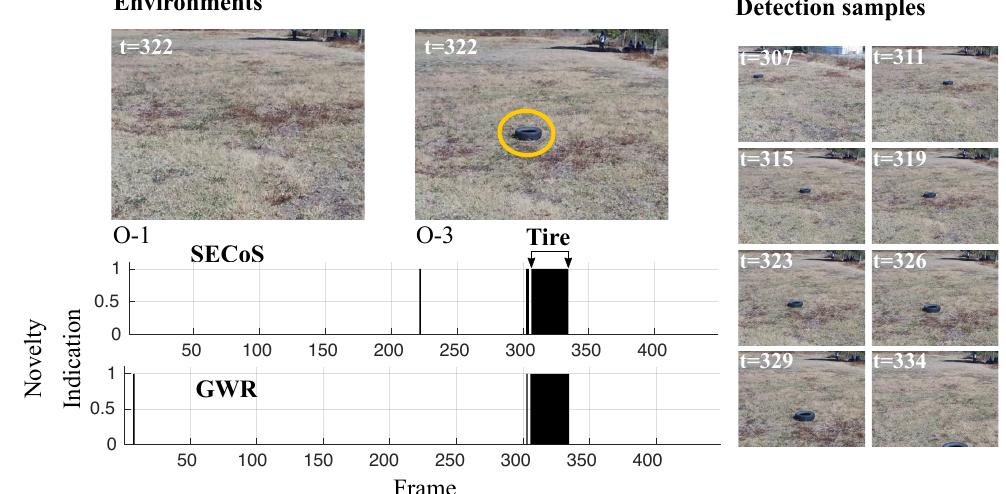
Figure 15. Visual results in novelty detection on dataset D-2, with the tire as the novel object.